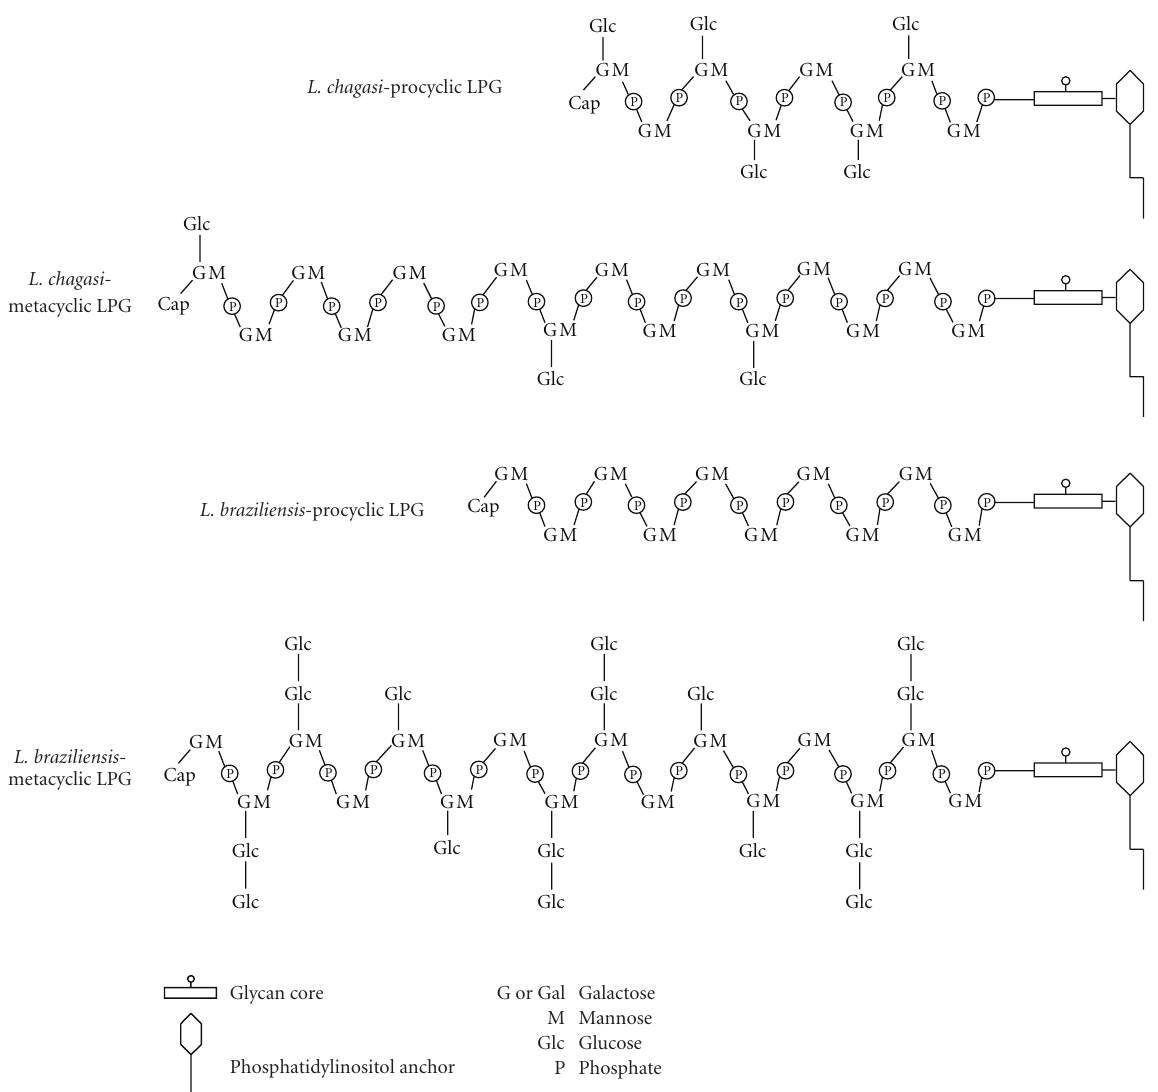
Figure 1: Opposite mechanisms in the glucose regulation in the LPGs from procyclic and metacyclic L. chagasi (syn. L. infantum ) and L. braziliensis [9, 10]. The structure of the glycan core is Gal( α 1,6)Gal( α 1,3) Gal f ( α 1,3)[Glc( α 1-PO 4 )-6]-Man( α 1,3)Man( α 1,4)GlcN( α 1,6) linked to 1- O -alkyl-2- lyso -phosphatidylinositol anchor. The repeat units are 6-Gal( β 1,4)Man( α 1)-PO 4 .